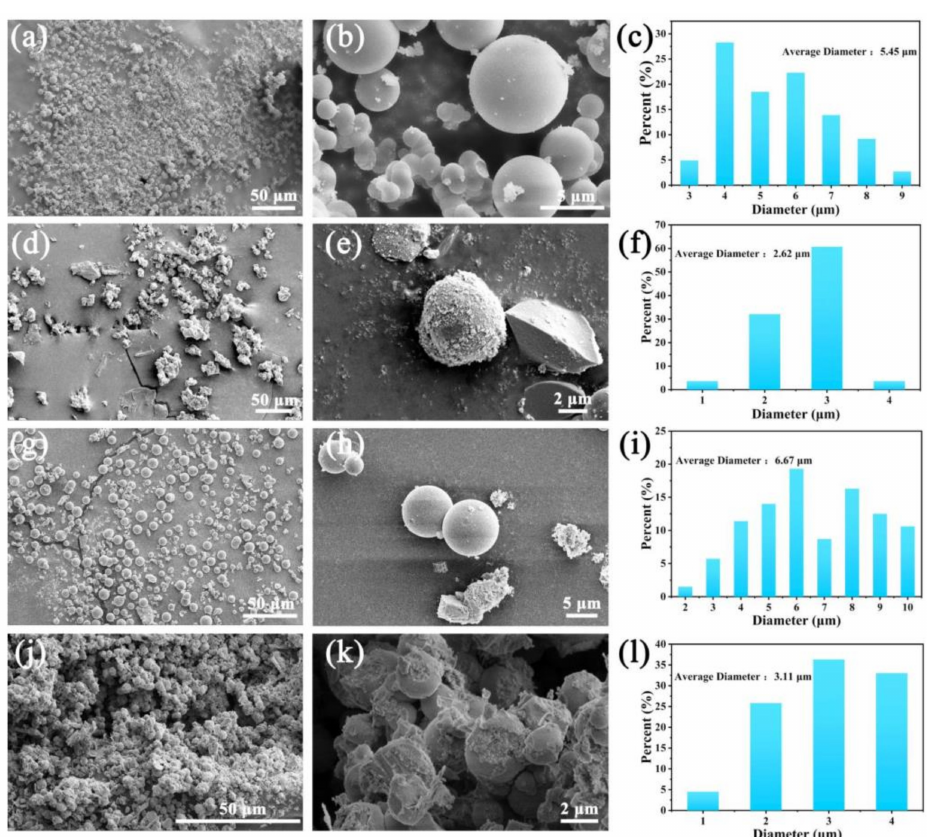
Figure 2. SEM images of ( a , b ) Ni-MOF; ( d , e ) NMO; ( g , h ) Ni/Co-MOF; ( j , k ) NCMO. Particle size of ( c ) Ni-MOF; ( f ) NMO; ( i ) Ni/Co-MOF; ( l )